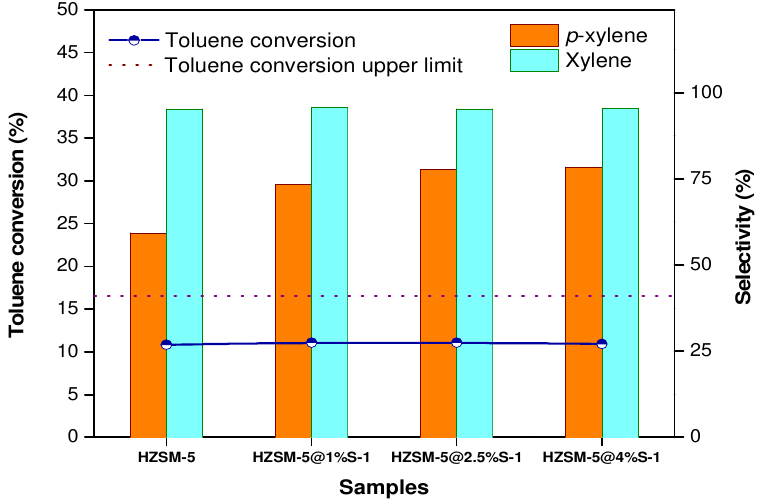
Figure 7. Catalytic performance of parent the HZSM-5 and HZSM-5@silicalite-1 catalysts in the